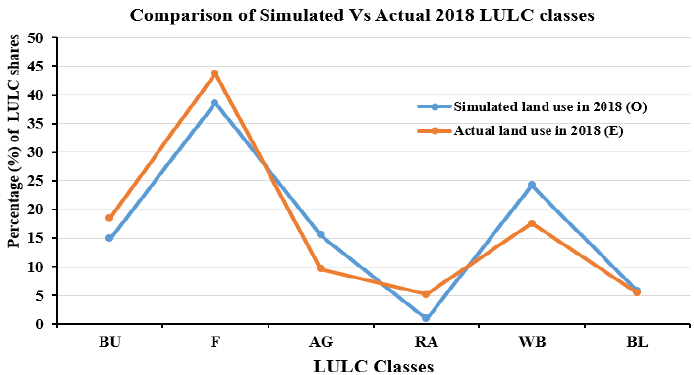
Figure 4. Comparison and model validation of areas (in percentage) of simulated vs. actual LULC classes in the year 2018. The LULC classes as designated as: BU—built-up area; F—forest area; AG—agricultural area; RA—reconstructed area; WB—water bodies; and BL—barren land. Table 4. Results of validation analysis of two images (agreement/disagreement components values).